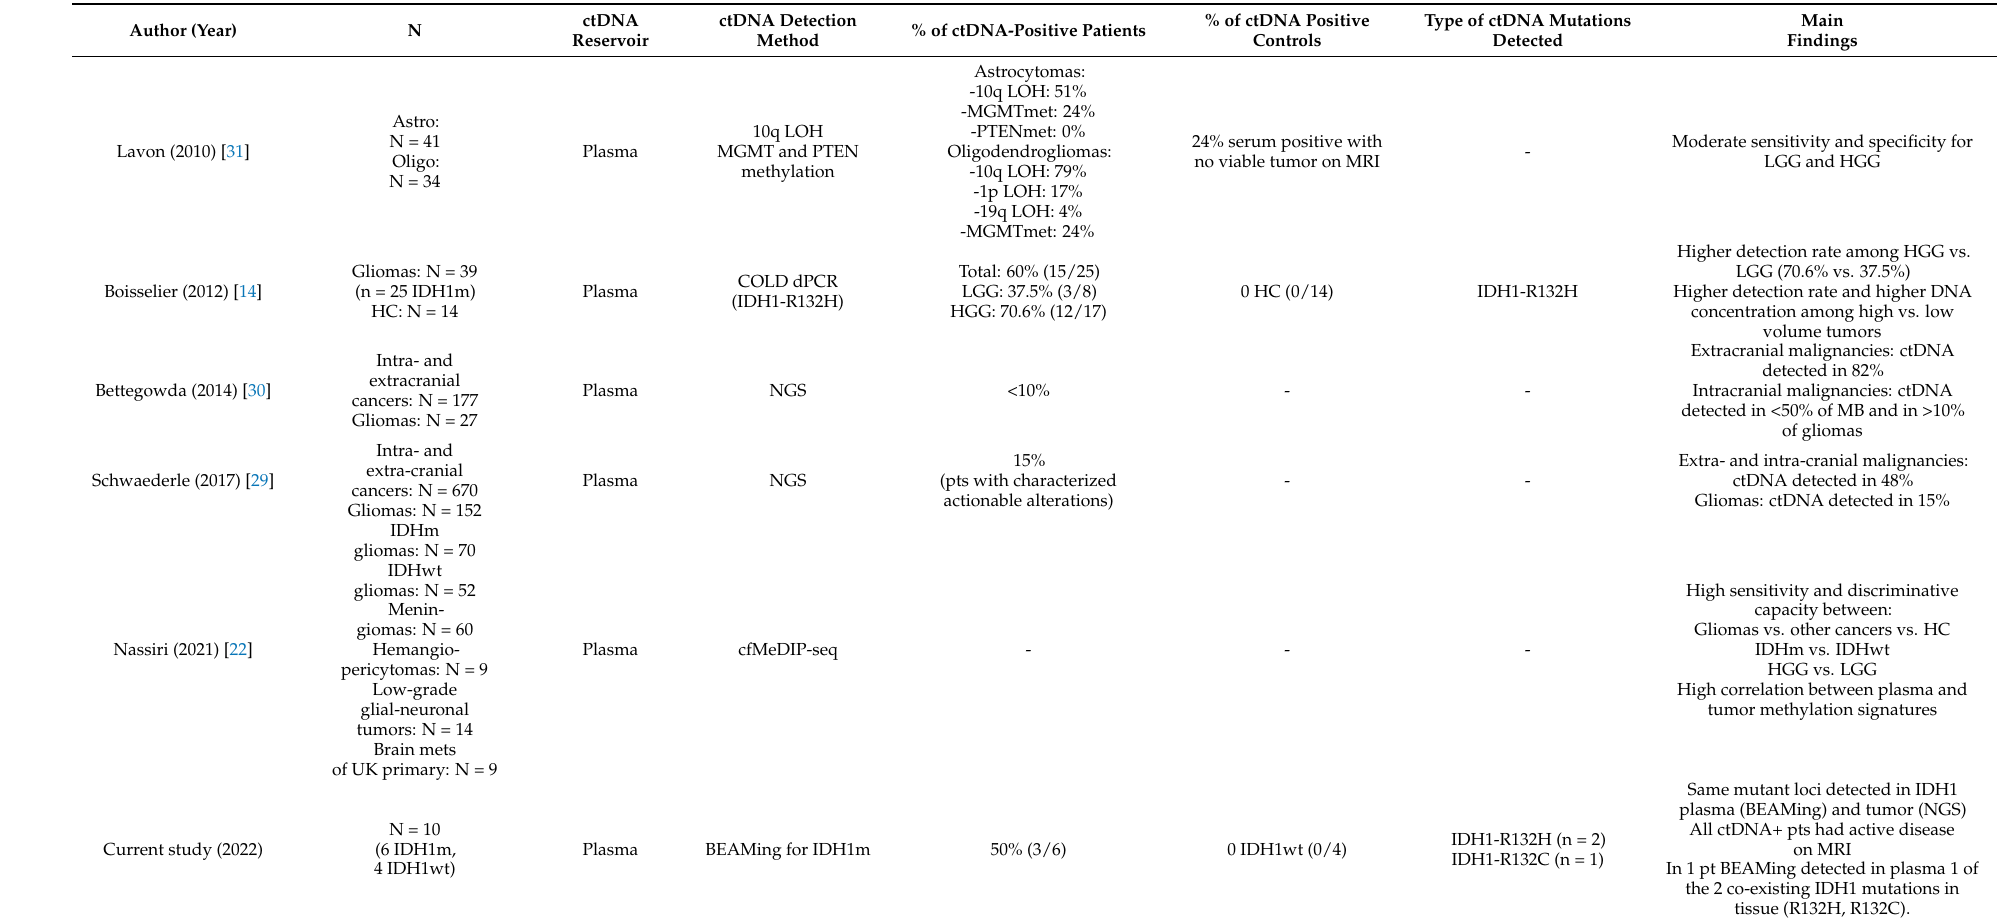
Table 3. Summary of studies of ctDNA in plasma in patients with